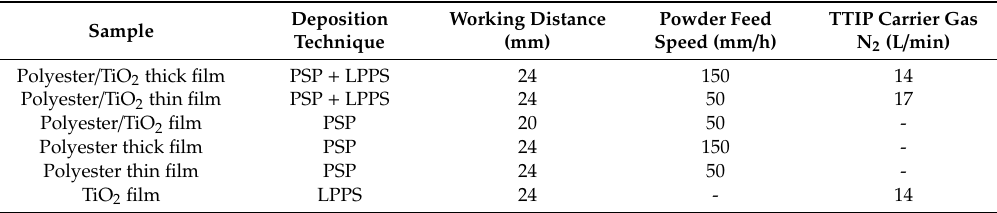
Table 1. Deposition